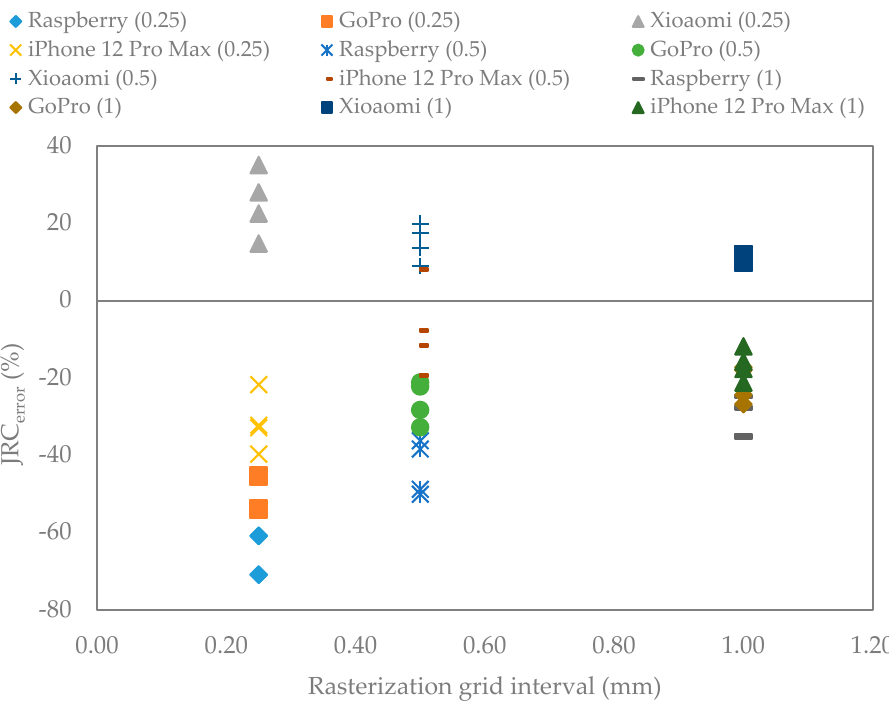
Figure 13. Mean value of the JRC error extracted from the fracture 3D models rasterized with grid intervals set to 0.25, 0.5, and 1 mm.